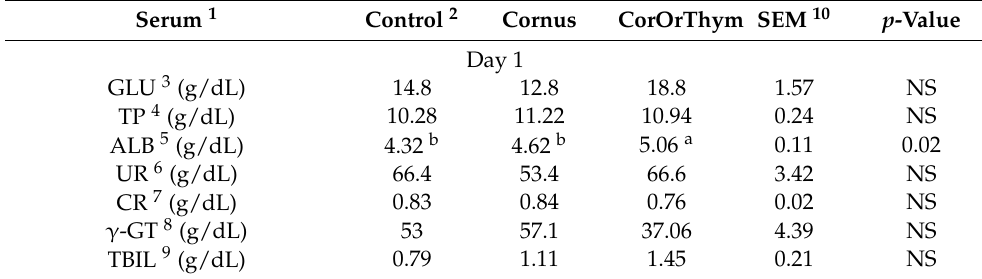
Table 11. Effects of diet supplementation with cornus extract and oregano and thyme essential oils on blood parameters 1 of dairy ewes on day 1 and day